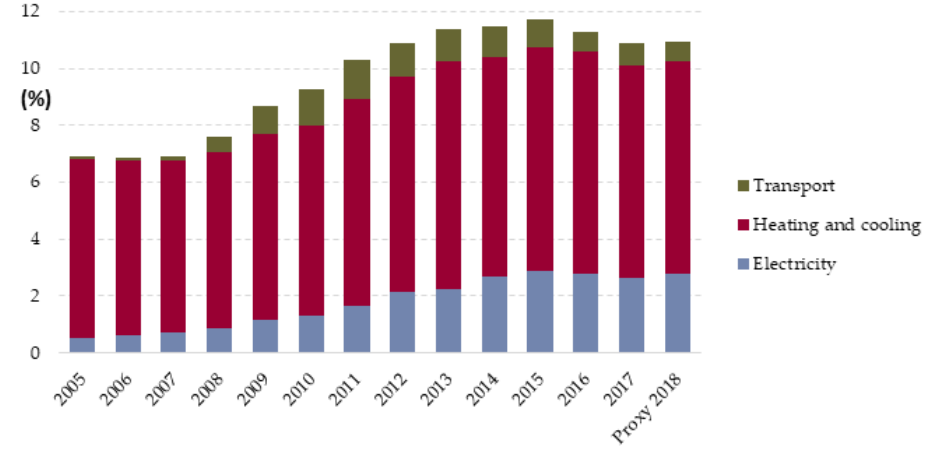
Figure 7. Share of renewable energy in gross final energy consumption in Poland [40].